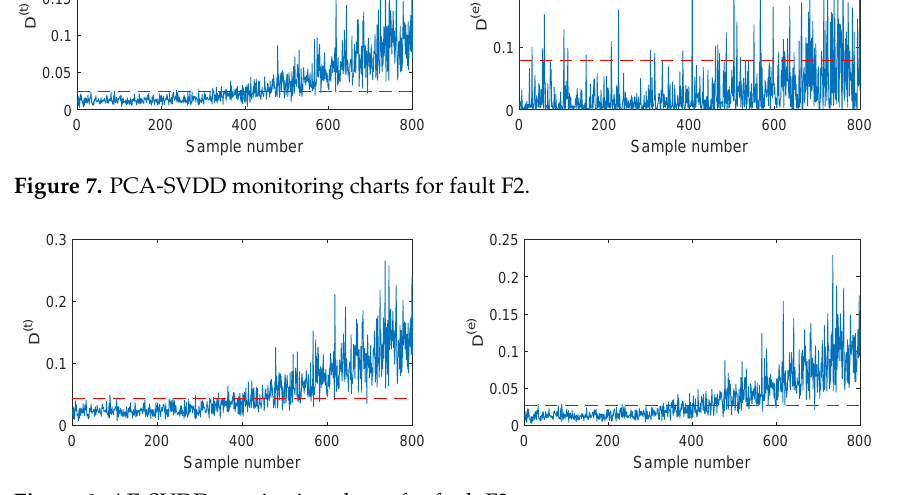
Figure 8. AE-SVDD monitoring charts for fault F2.